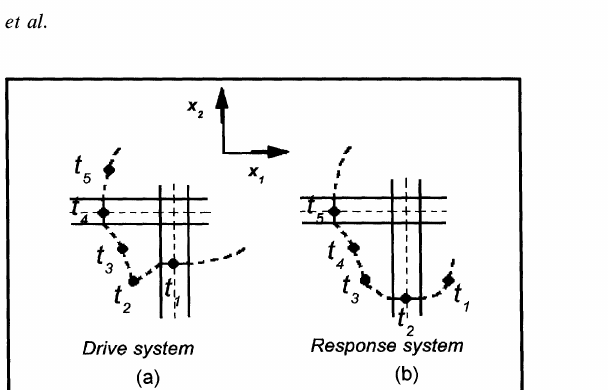
FIGURE 5 The path to synchronization in the flat region of the (a) drive subsystem and (b) the response